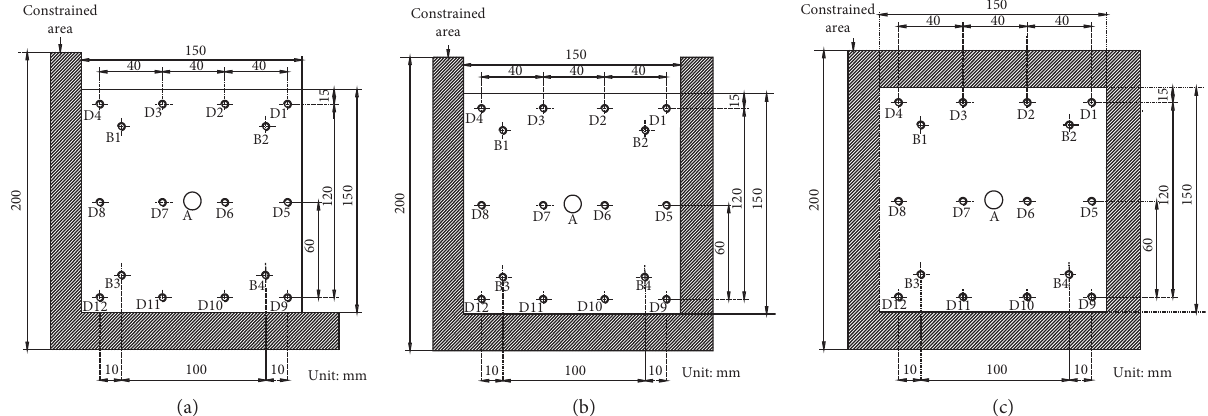
Figure 5: Dimensions of the baseplate under different boundary conditions. (a) Two ends clamped (C-C-F-F), (b) three ends clamped (C-C- C-F), and (c) four ends clamped (C-C-C-C).